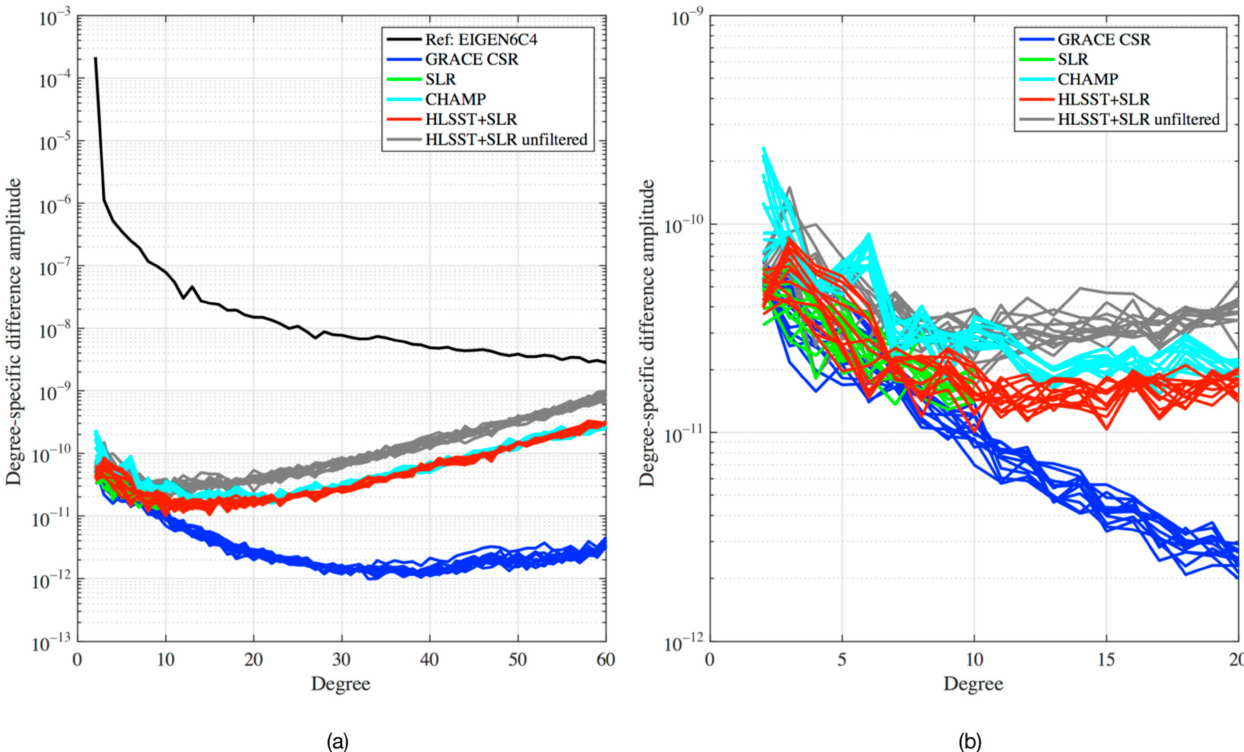
Figure 3. Degree-specific difference amplitudes of the monthly gravity solutions with respect to EIGEN-6C4 over the year 2005. Figure ( a ) displays spectrum ranging up to degree 60, while ( b ) focuses on low degrees ranging up to degree 20. Two sets of solutions—HLSST+SLR solutions and HLSST+SLR unfiltered solutions are shown here. CHAMP is the filtered solutions by applying the Kalman filter. No filtering is applied to GRACE CSR and SLR solutions. The black line is the degree variances of coefficients from